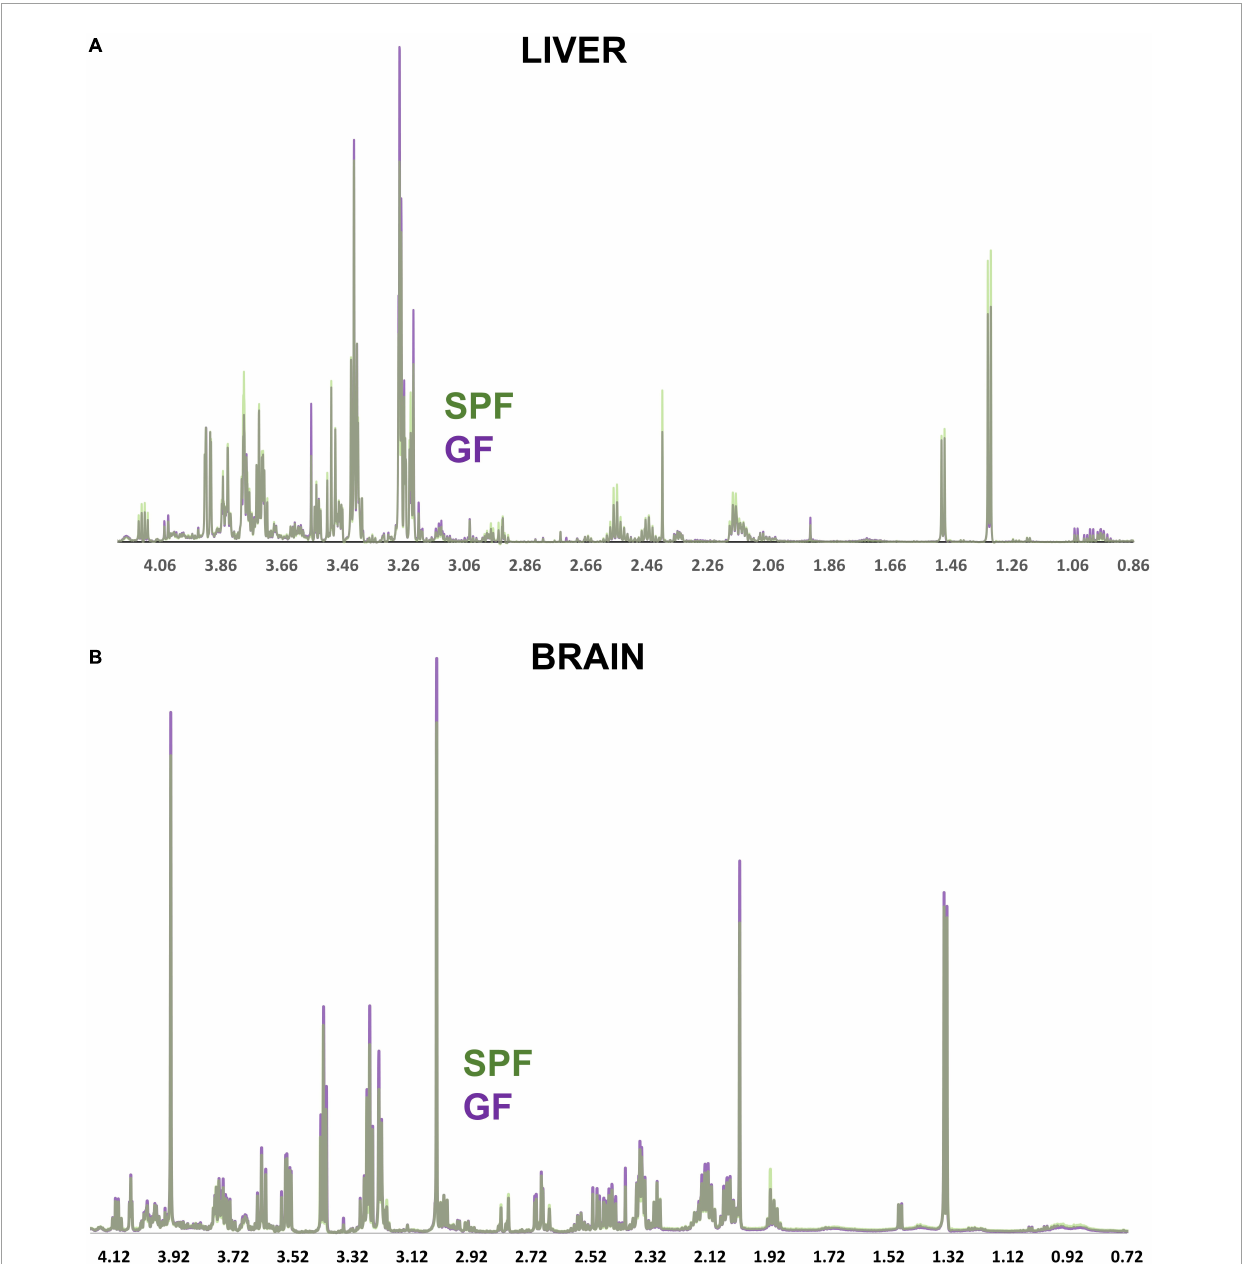
FIGURE3 NMR spectra comparing the GF and SPF liver and brain metabolome. (A) Median spectral intensity of the GF (purple, n = 6) and SPF (green, n = 6) liver metabolome. (B) Median spectral intensity of the GF (purple, n = 6) and SPF (green, n = 6) brain metabolome. Several metabolites were altered by absence of bacterial flora in both liver and brain GF tissue ( Figures 4 , 5 ). In the brain, taurine, myoinositol, creatine, glutamate, glutamine, choline, and NAA were significantly increased in GF mice relative to SPF animals ( Figure 4 ). Conversely, acetate and various lipoprotein resonances were reduced in GF animals ( Figure 4 ). Inspection of the corresponding loadings plot indicates that cerebral lactate and taurine levels may have contributed to the variation observed in the GF mice brain samples ( Figure 2B